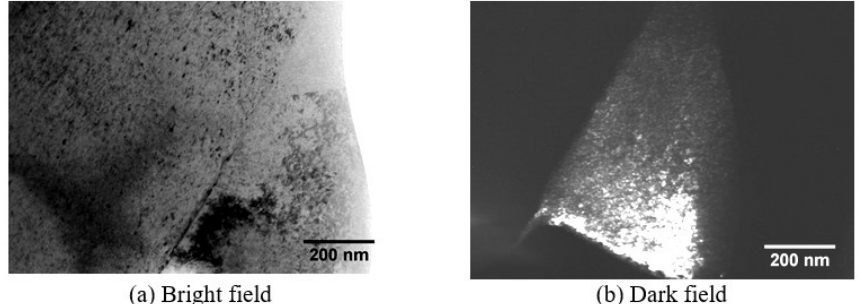
Figure 5. TEM images of the Inconel 718 as received.